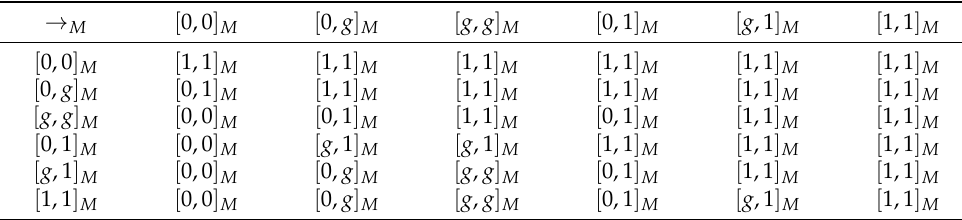
Table 8. The operation → M of algebra in Example 8.